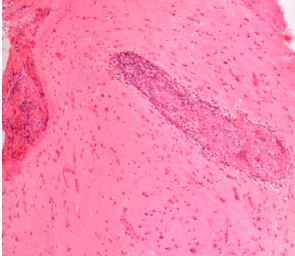
Figure 4. Neurosarcoidosis. H&E. Magnification 100×.